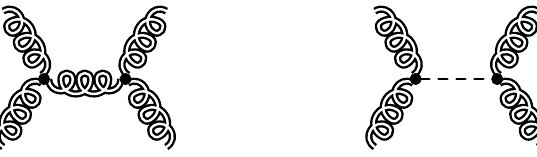
Figure 1: Usual and potential additional s -channel diagrams contributing to 2 the dual